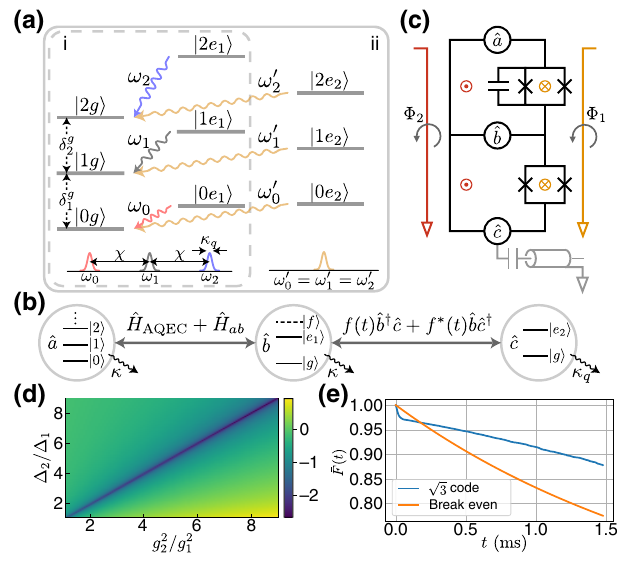
FIG. 4. Circuit implementation of the discovered AQEC scheme. (a) Level diagram and emission spectrum before (i) and after (ii) erasing the which-way information. (b) Schematic interactions within the extended system with an additional lossy qubit ˆ c . (c) Circuit design that implements the desired interac- tions by modulating the flux threading the smaller (yellow) and B as a function of g 2 / g 2 and (cid:14) 2 /(cid:14) 1 , larger (red) loops. (d) log 10 2 1 /(cid:14) ≈ g 2 /(cid:14) which is minimized when g 2 1 2 . The simulation is 1 2 performed with (cid:14) 1 / 2 π = 1 GHz and g 1 / 2 π = 100 MHz. (e) √ 3 code from a time-domain simulation Average fidelity of the of the full circuit dynamics.